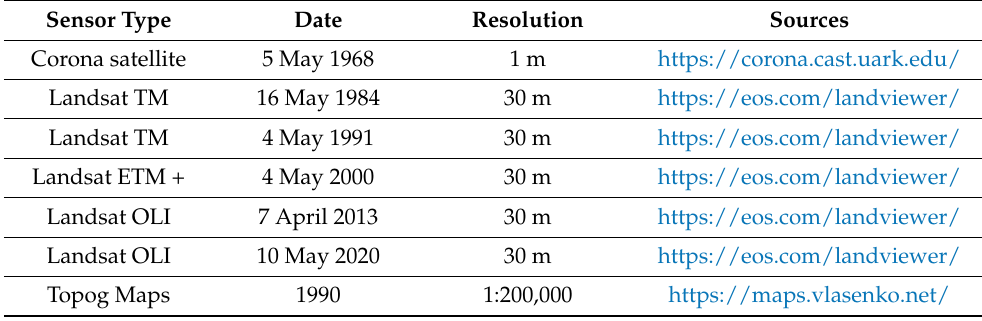
Table 1. The list of satellite imagery data that were used in this